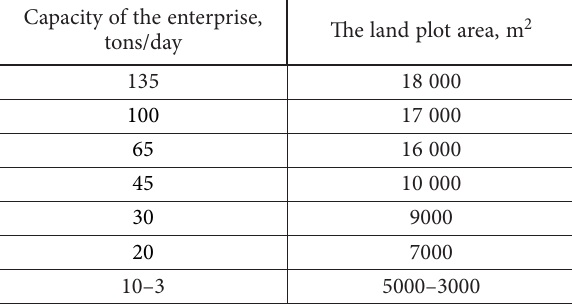
Table 1. Typical sizes of land plots of Ukrainian